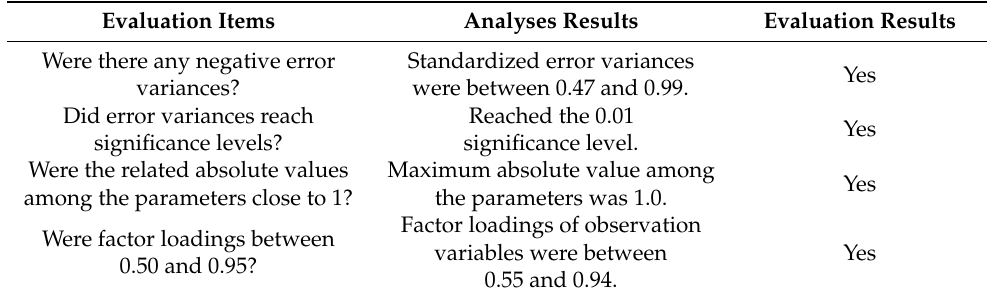
Table 2. Analysis results of preliminary fit in the theoretical model of intention to stay ( n = 272).